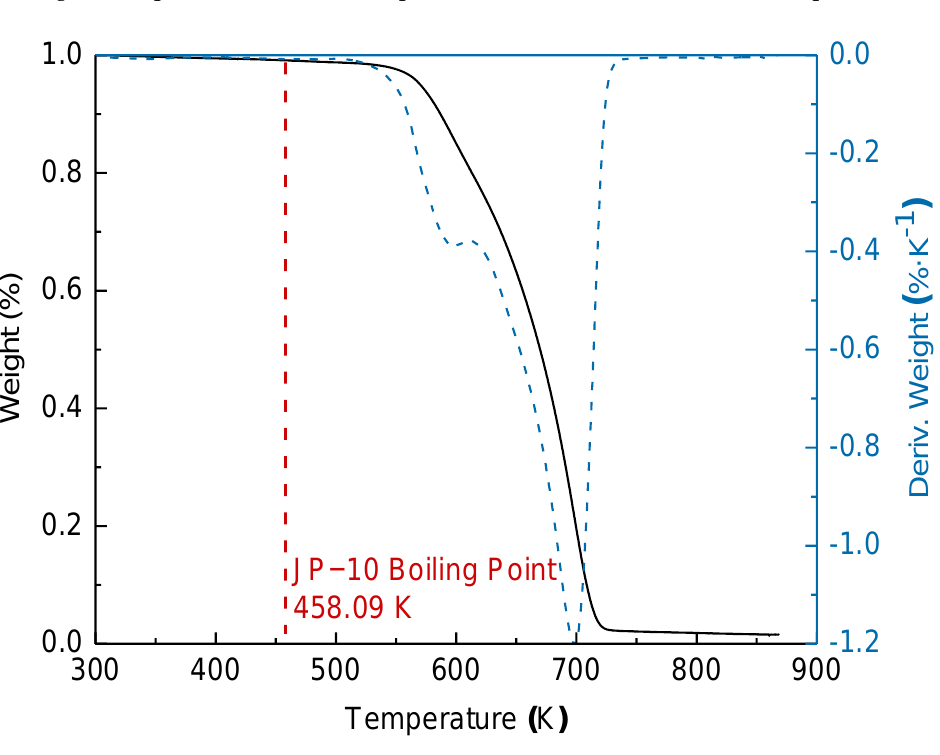
Figure 3. Thermogravimetric analysis of hyperbranched polyester (HPE).